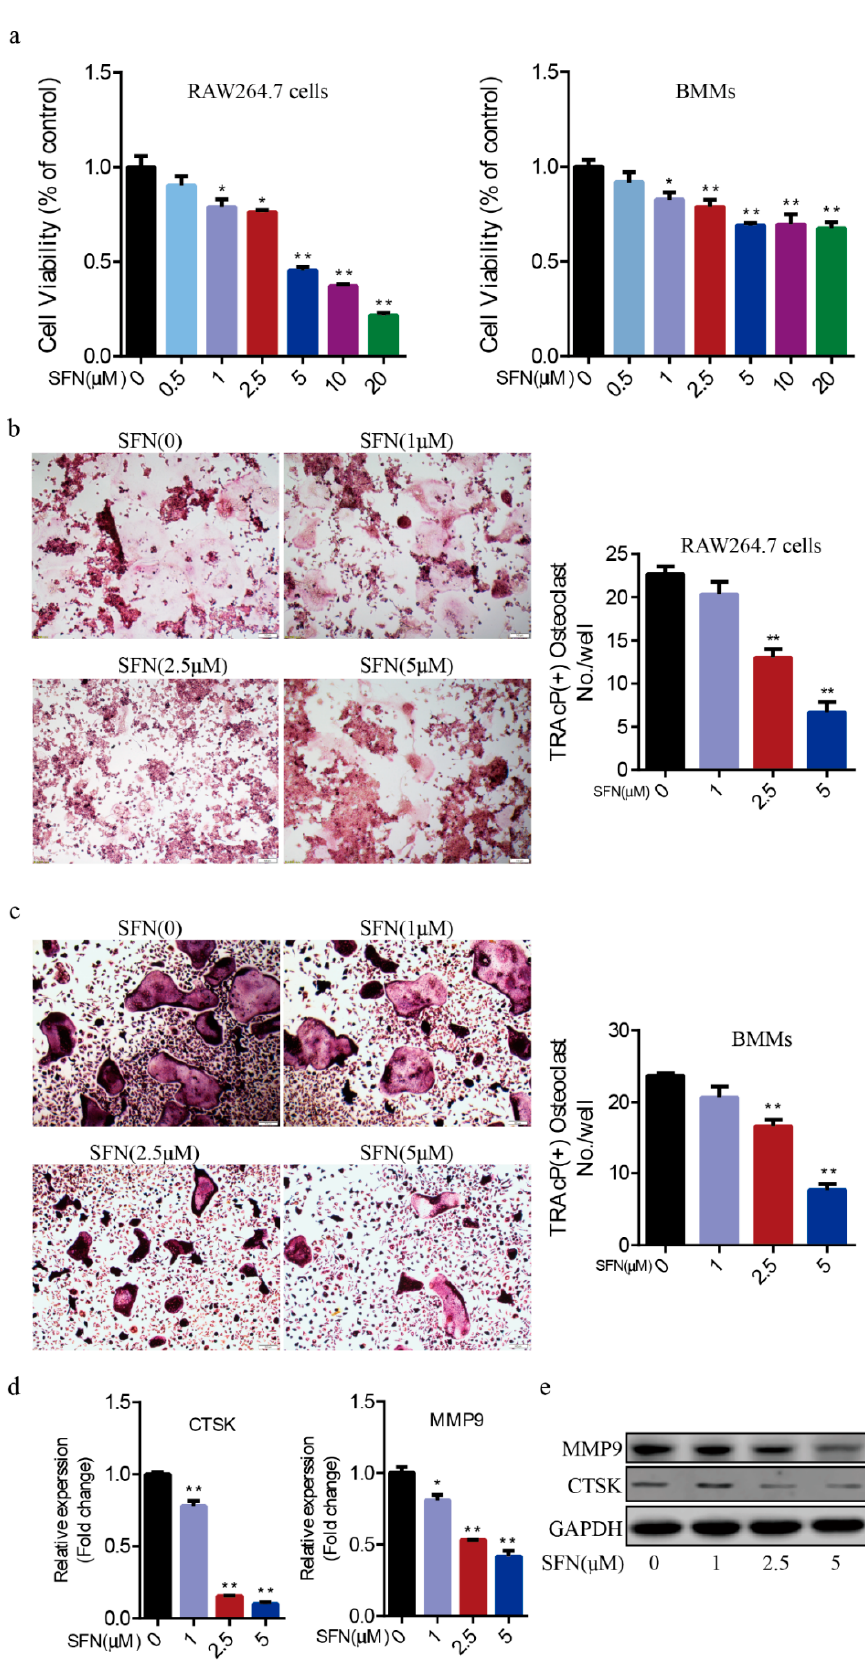
Figure 1. Sulforaphane (SFN) inhibited osteoclastogenesis in a dose-dependent manner. ( a ) The proliferative activity of RAW264.7 cells and bone marrow macrophages (BMMs) was detected by Cell Counting Kit-8 (CCK-8) assay after 24 h in the presence of the indicated concentration of